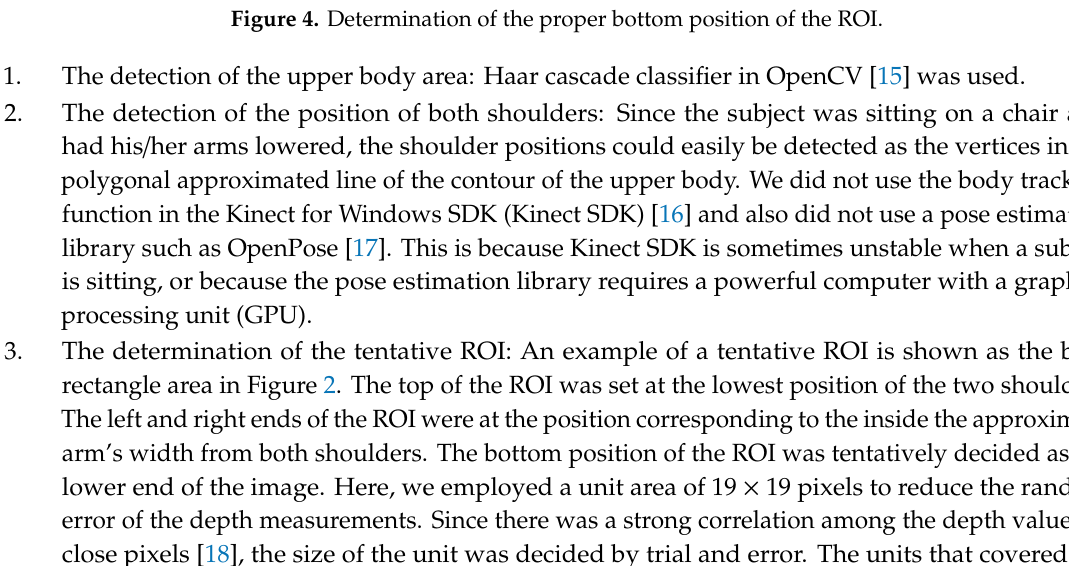
Figure 4. Determination of the proper bottom position of the ROI.